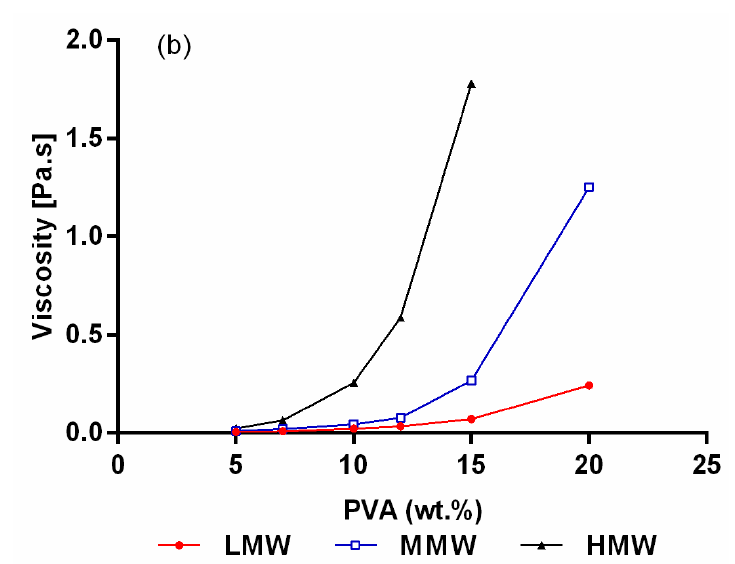
Figure 1. ( a ) Influence of molecular weight and PVA concentration on viscosity. ( b ) Viscosity of blended PVA/TE dispersions solutions in the ratio of 60:40 (error bars are smaller than the symbol size).